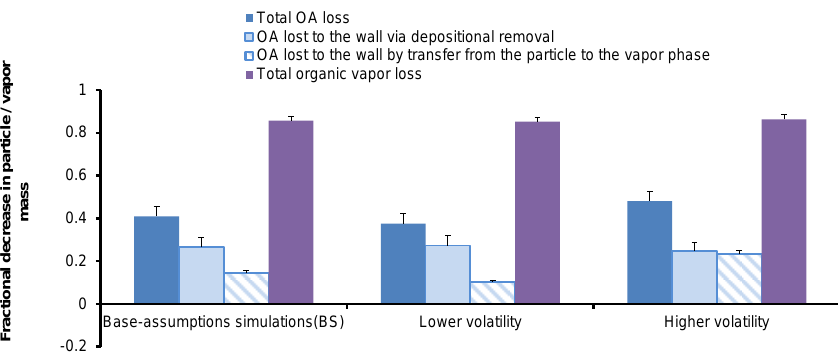
Figure 6. The organic species mass budgets for the base-assumption simulations and two sensitivity studies using bounding volatility distri- butions. All other variables as in Fig. 3b.